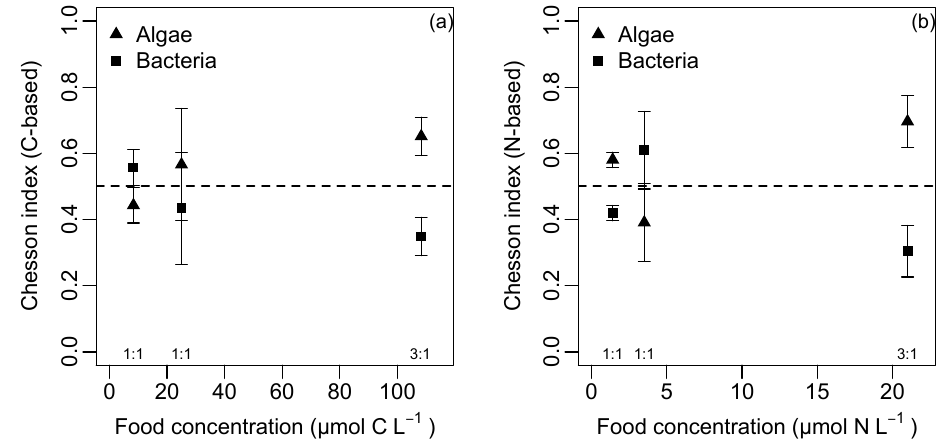
Figure 5. The Chesson index of L. pertusa for feeding on bacteria and algae expressed in (a) carbon and (b) nitrogen. The mean ± range is shown for the low food concentration treatment ( n = 2). The ratios 1 : 1 and 3 : 1 in both sub-panels indicate the ratio of bacteria:algae in the respective food concentration